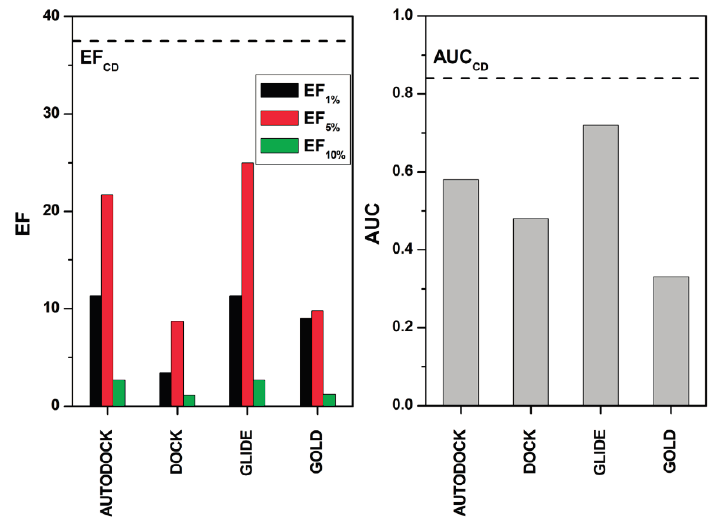
Figure 2. AUC (right plot) and EF (left plot) analysis for the four docking procedures. The black line indicates the EF and AUC values obtained by applying the consensus docking